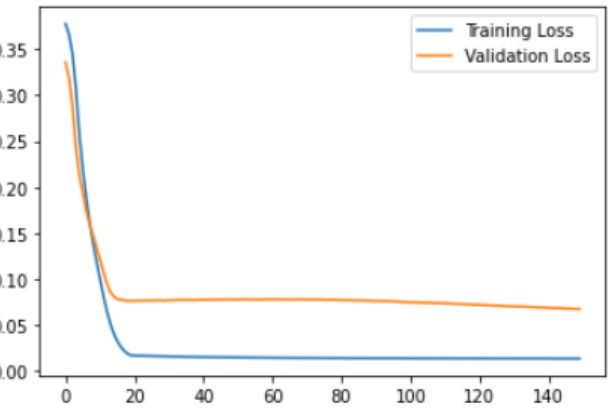
Figure 12. Training and validation loss.